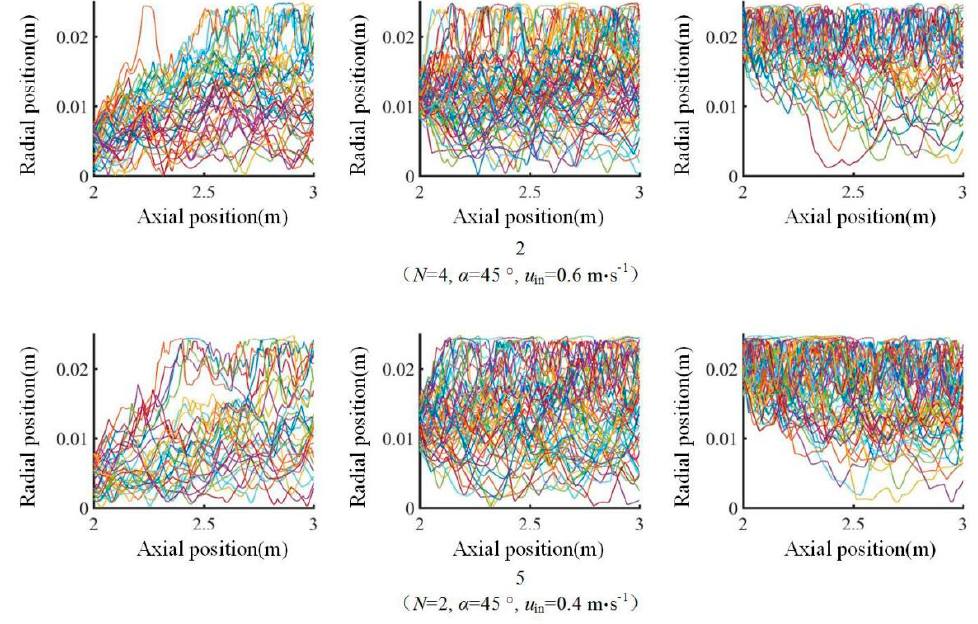
Figure 12. Changes in the radial positions of particles in the three initial regions in test 2 and test 5.